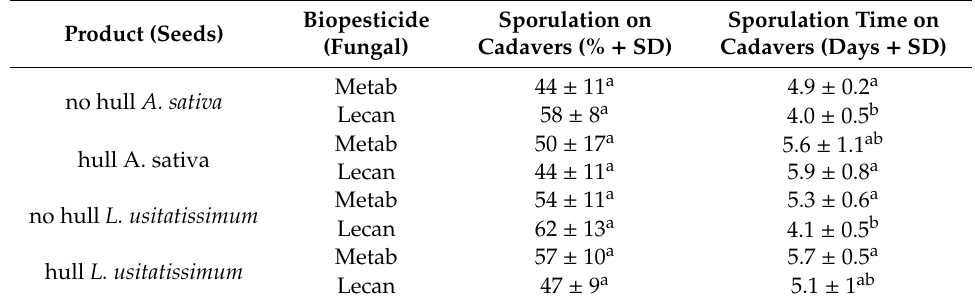
Table 6. The sporulation percentage and sporulation time on cadavers of T. confusum . Mean ± SD values with the same letter within a column are not significantly di ff erent ( p <